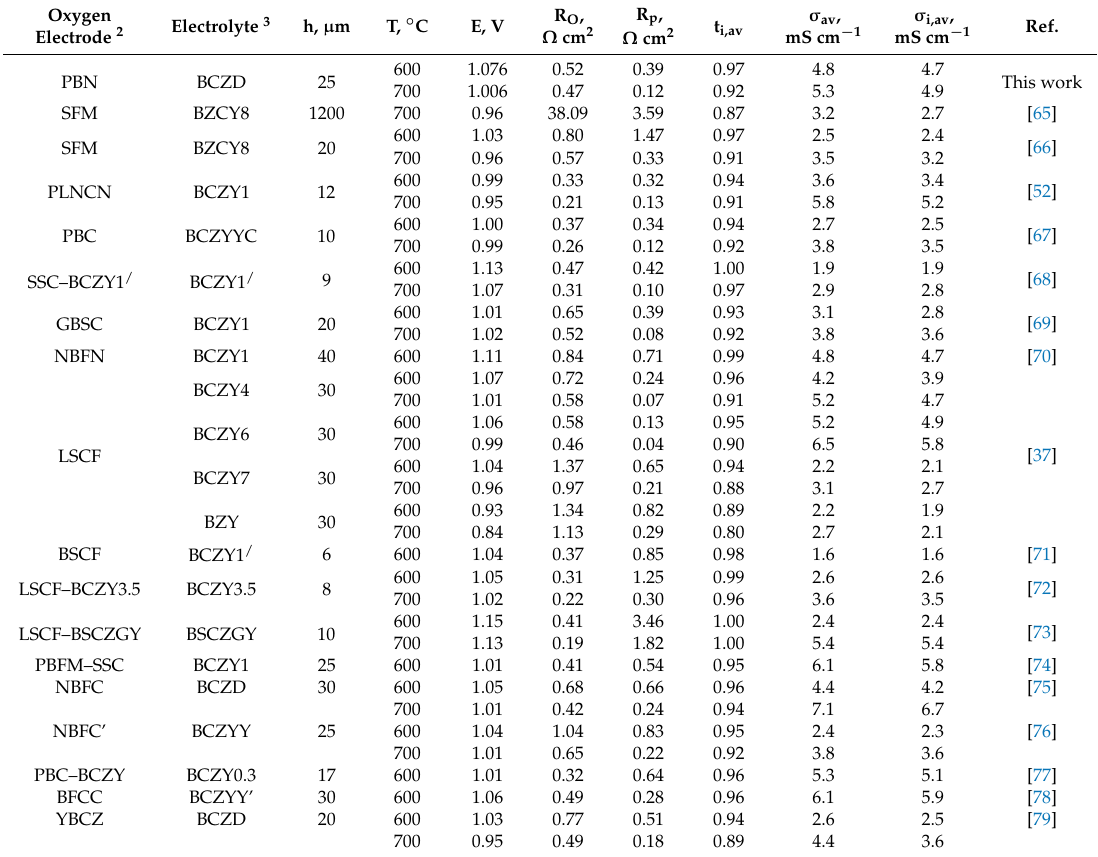
Table 2. Electrolytic properties of proton-conducting membranes of PCCs under OCV conditions 1 : h is the thickness, T is the temperature, E is the OCV, R O and R p are the ohmic and polarization resistances, t i,av is the average ionic transference number, σ av and σ i,av are the average values of total and ionic conductivities of the electrolyte